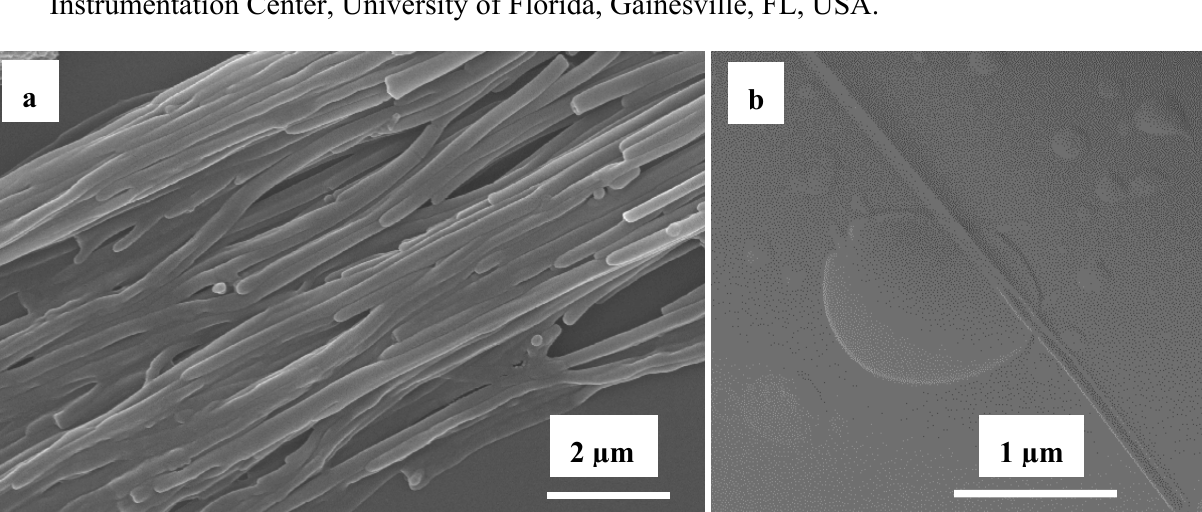
Figure 10. Scanning electron micrographs of lignin nanotubes prepared according to the protocol in reference 235 ( a ) Overview image showing a bundle of lignin nanotubes from a partially dissolved alumina membrane; bar = 2 μ m. ( b ) An individual lignin nanotube with an incomplete wall, revealing the lumen of the tube; bar = 1 μ m. Images were acquired on a JEOL JSM 6335F field-emission scanning electron microscope at the Major